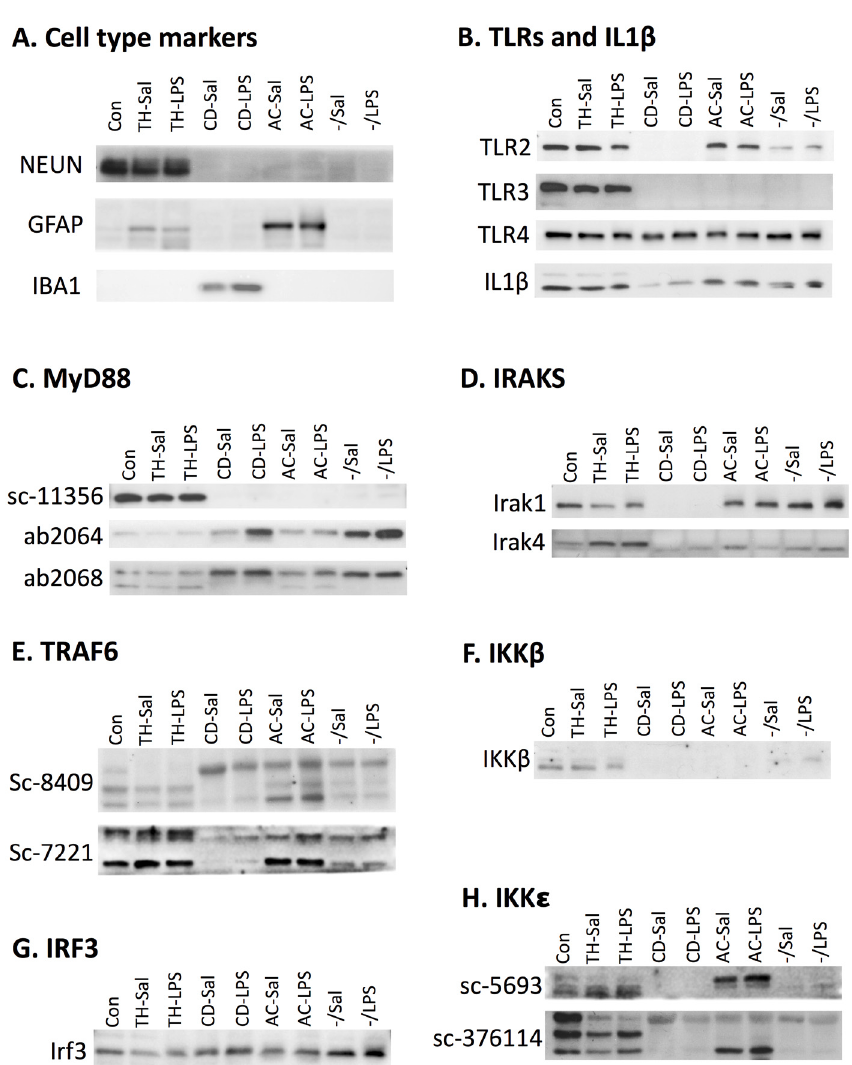
Figure 7. Protein expression in fractions. Fraction protein expression in representative western blot images. Number of experiments for each antibody are indicated in parenthesis. A. Cell-type specific antibodies verify cell-type enrichment in the fractions. NEUN, a neuronal marker, is expressed in the control sample and the total homogenate (TH) (n=3). GFAP, an astrocytic marker, is expressed in low levels in the TH and higher levels in astrocytes (n=2). IBA1, a microglial maker, is expressed in microglia (n=3). B. Expression for TLR2 appears to be in all fractions except microglia (n=3), while TLR3 is only detected in the TH (n=2), and TLR4 (n=2) and IL-1 β (n=3) are detected in all fractions C. Blotting with three different MyD88 antibodies produced different results (n=3 for each). Sc-11356 suggested MyD88 is only